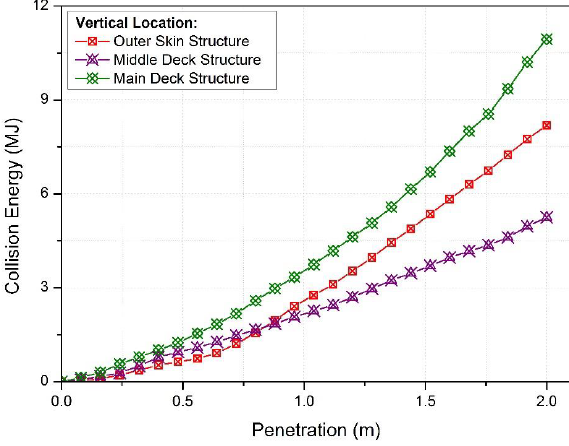
Figure 14: Energy pattern for different structure members.